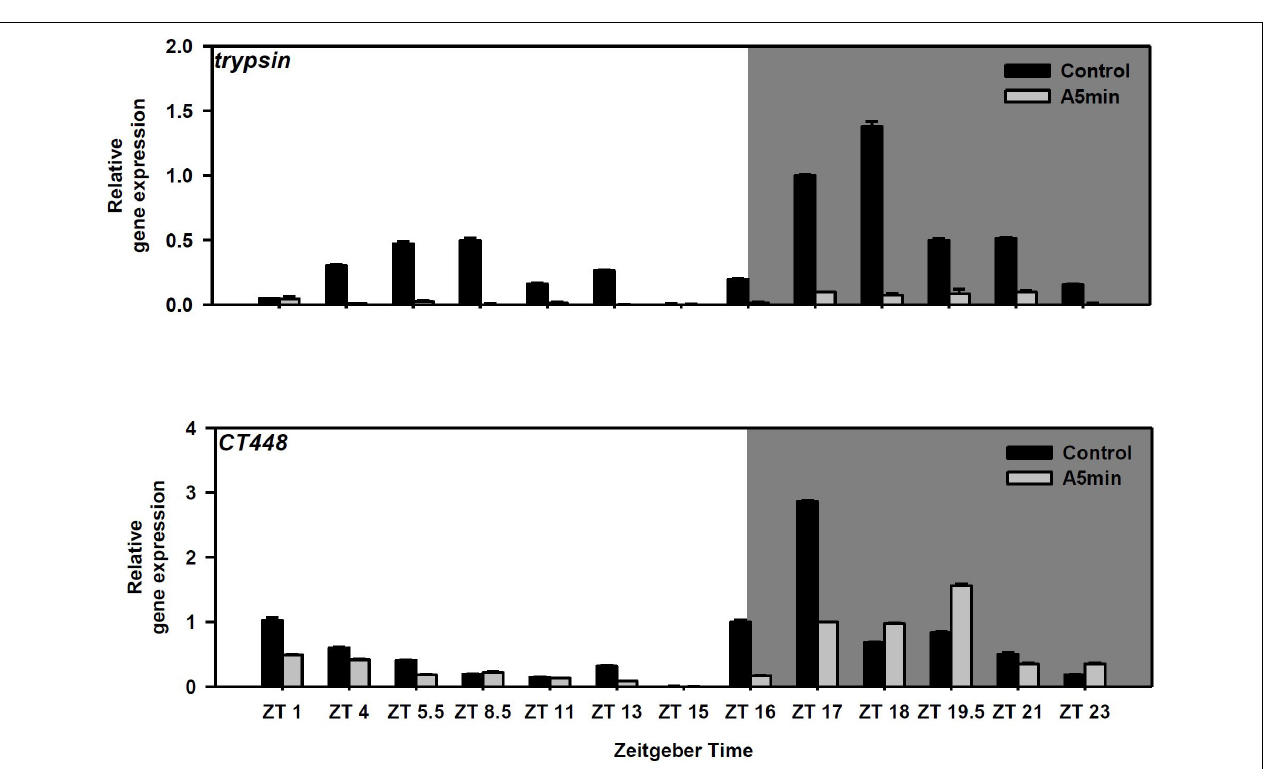
FIGURE 2 | Gene expression of trypsin and a chymotrypsin gene ( CT448 ) over 24 h in a day-night cycle of 16:8 h (control) and in ALAN (A5 min: 5 min light every hour of the night; N = 3, mean + SD). Shaded area: night, white area: